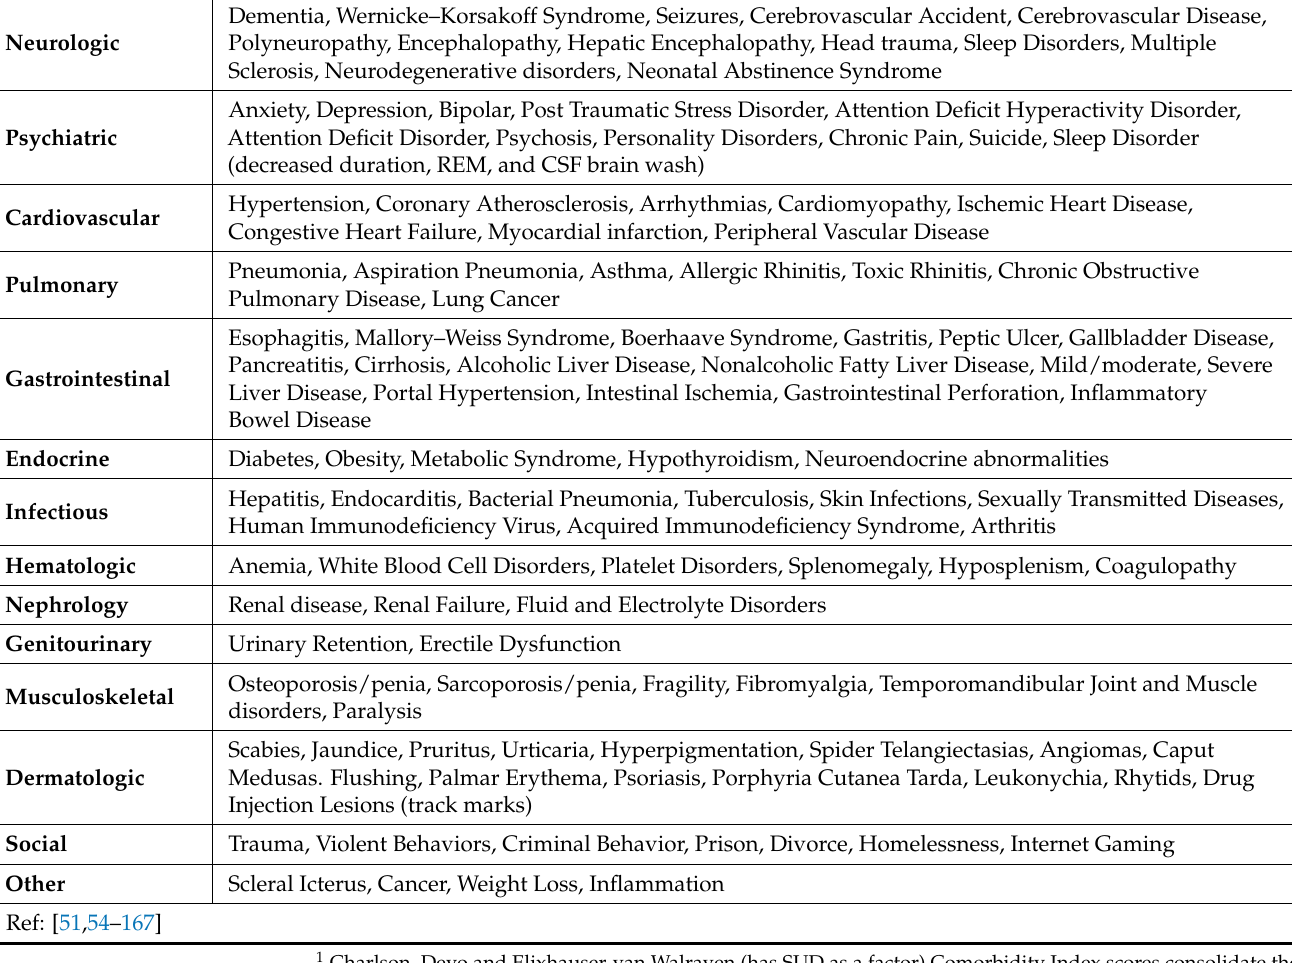
Table 1. Common medical comorbidities of SUD.